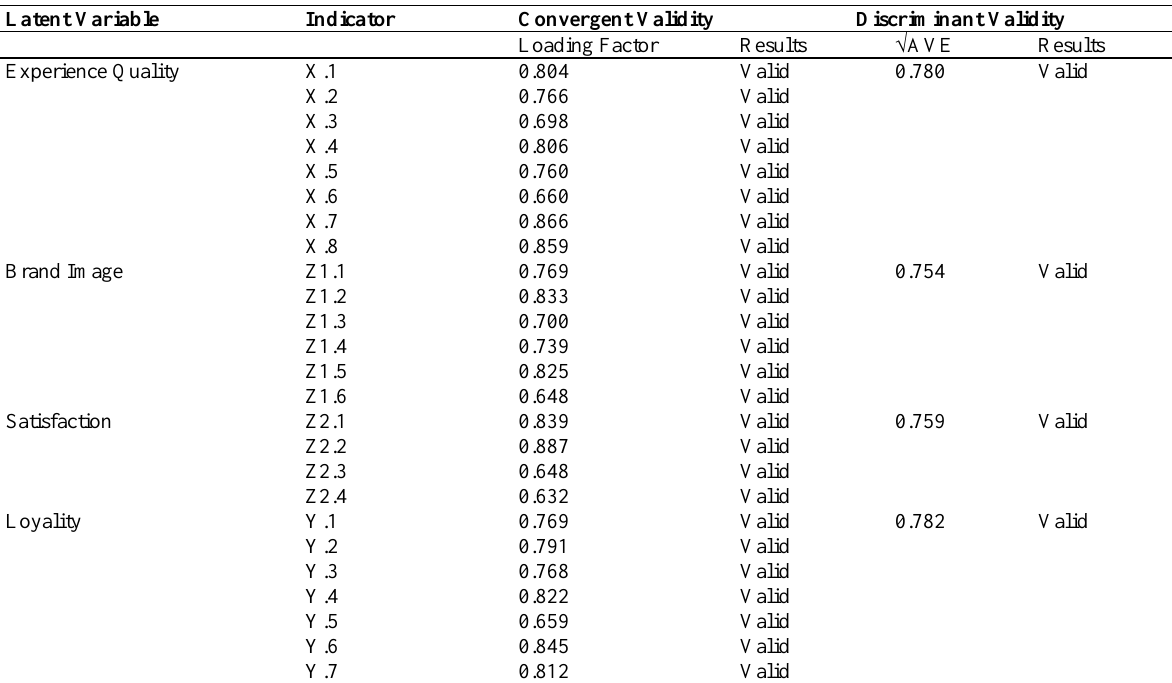
Table 4: Validity Analysis